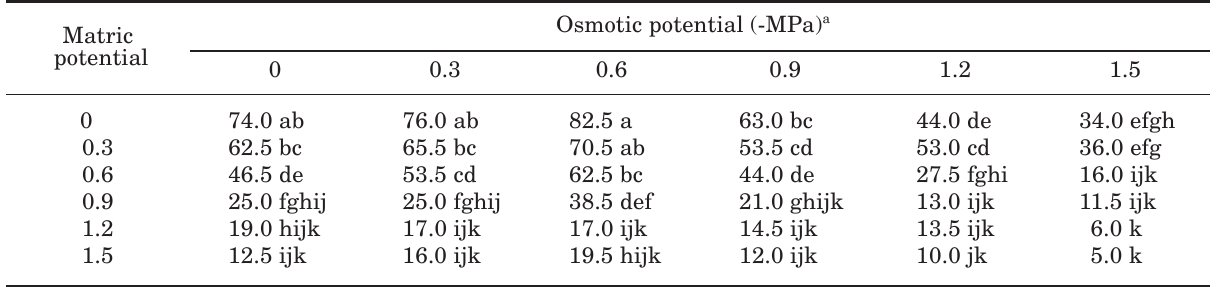
Table 1. Effect of matric and osmotic potential and its interaction on microsclerotium germination (%) of Verticil- lium dahliae.